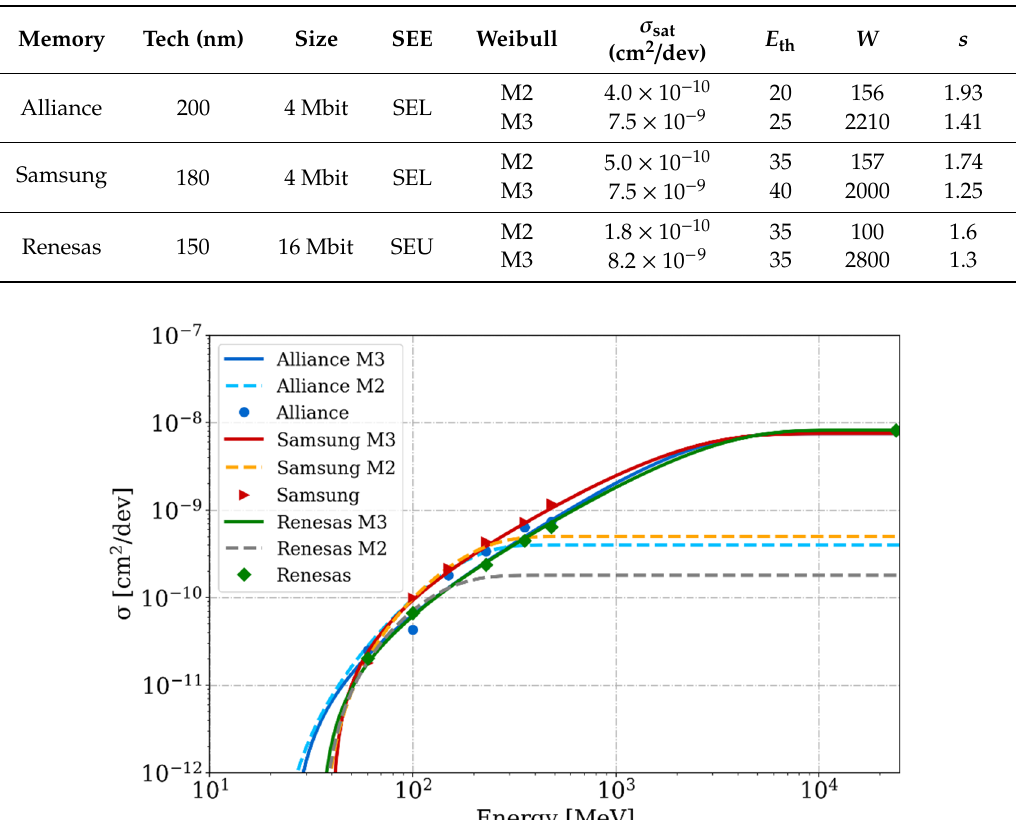
Figure 4. SEL and SEU cross sections for the three SRAMs calculated from two different Weibull: standard characterization at 230 MeV (M2) and response up to several GeV (M3). Experimental data are shown with markers.